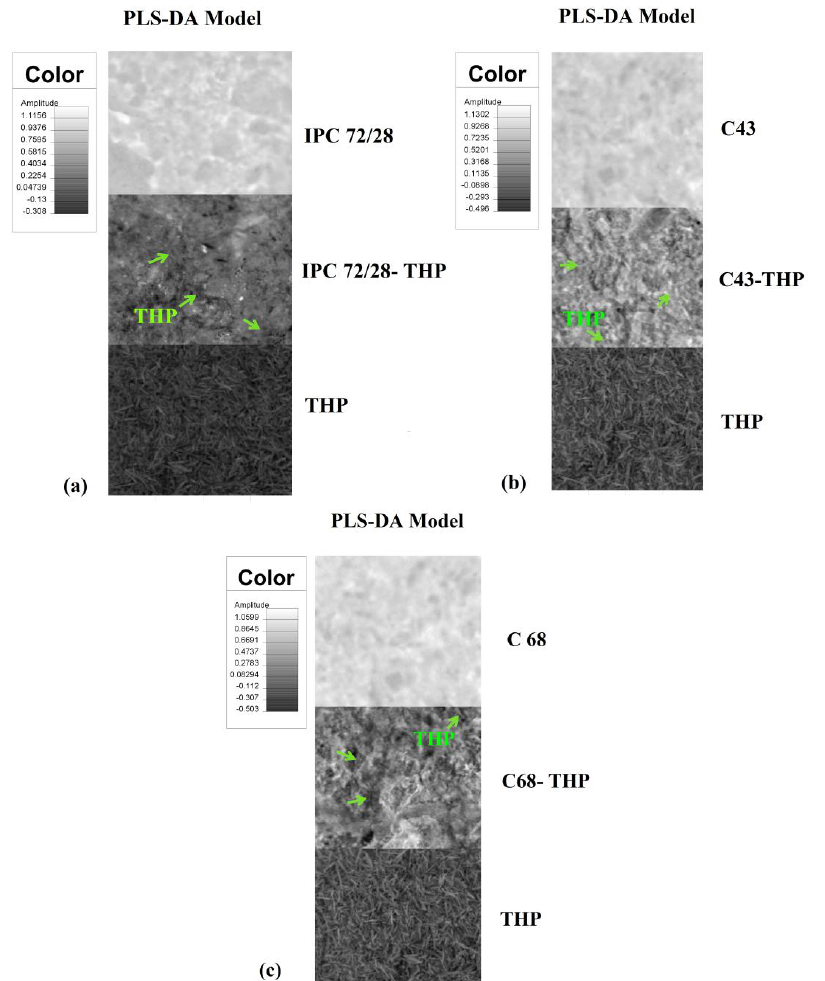
Figure 1. Partial least squares-discriminate analysis (PLS-DA) model images obtained for ( a ) interpolymeric complexes (IPC) 72/28 ( b ) C43 and ( c ) C68 copolymers. Table 1. Evaluation of the theophylline (THP) loading of the IPC and graft copolymers by the near infrared (NIR) method.